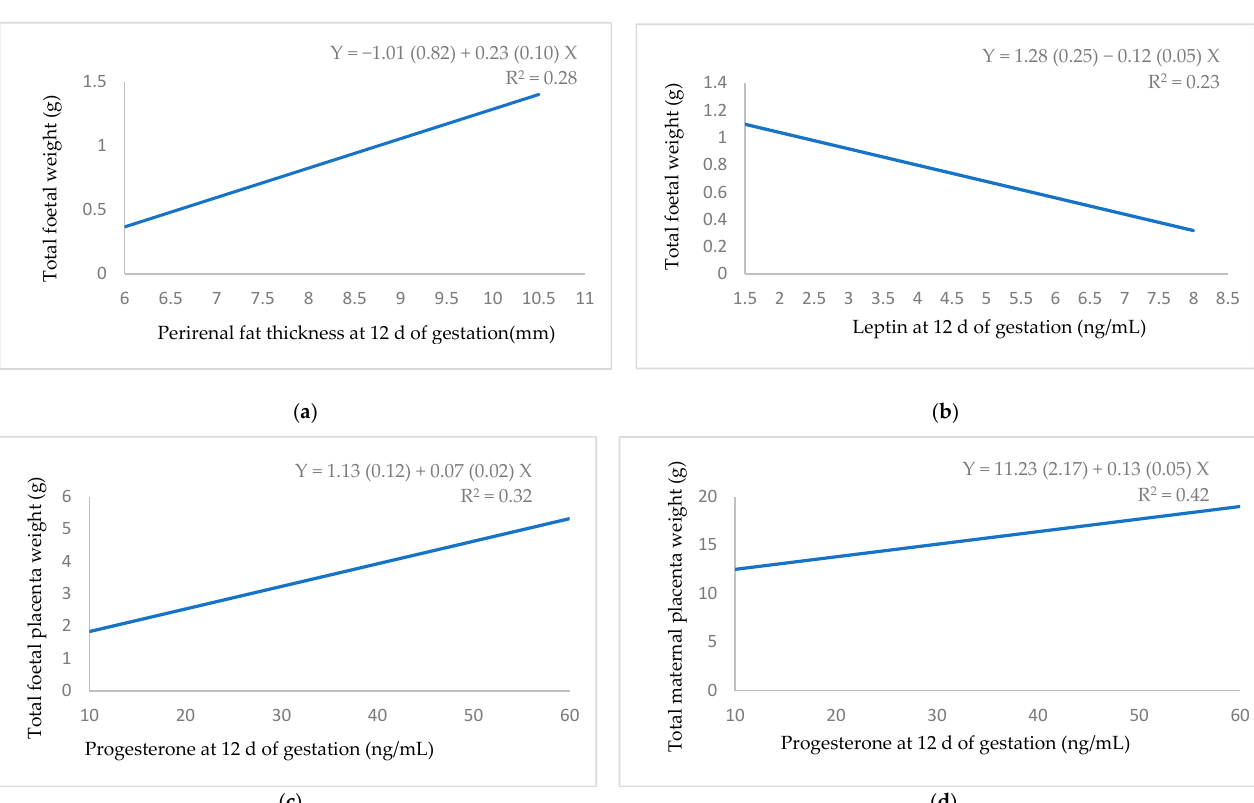
Figure 2. Regression equation (standard error between brackets) at mating for the relationship between ovulation rate: ( a ) NEFA; ( b ) 17 β -estradiol; ( c ) leptin.